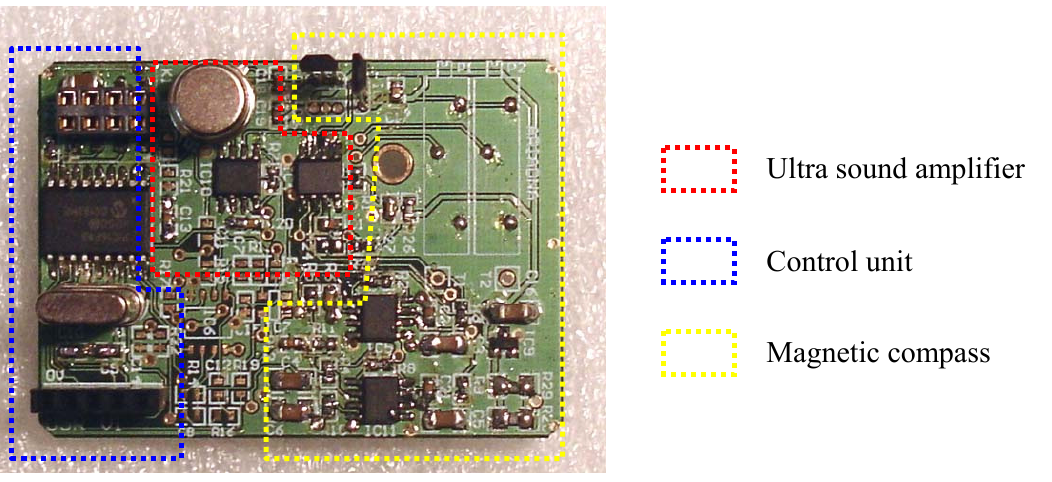
Figure 24 . Ultrasound receiver PCB layout